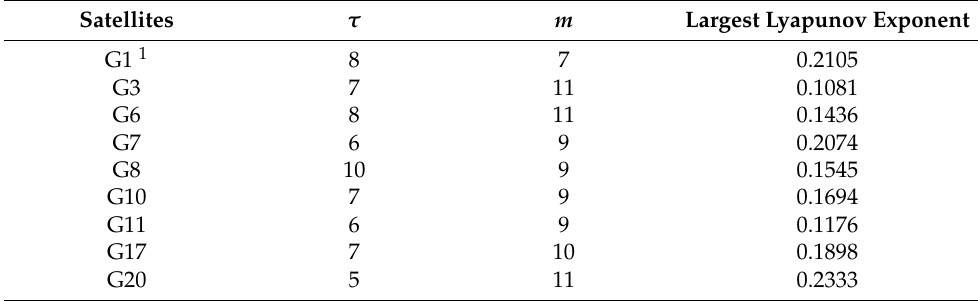
Table 1. Chaos indices of the visible